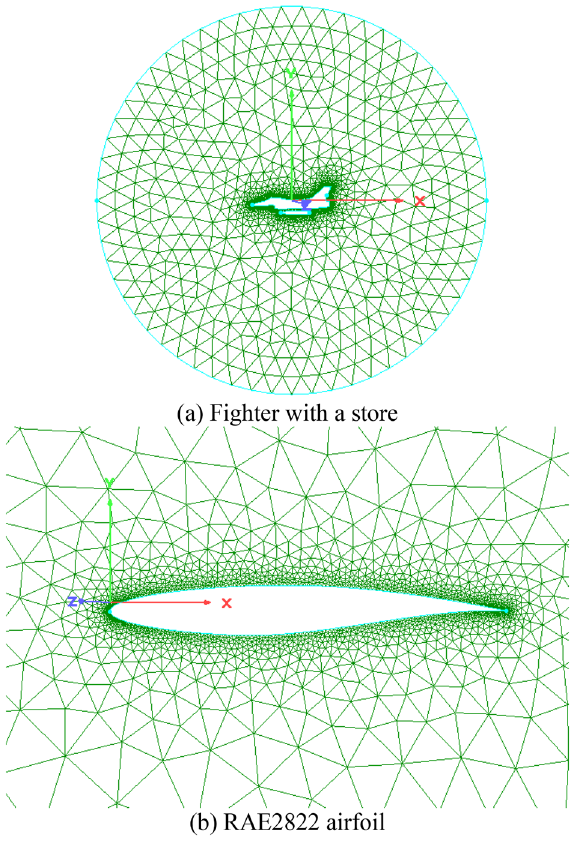
Figure 10. Training samples generated by the traditional AFM.